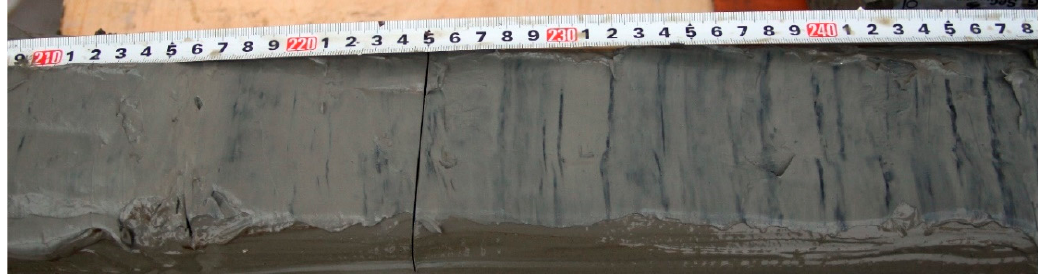
Figure 11. Core ONG-4. Banded diagenetic structure in Holocene silty-clay (Lithological units 1 and 2). Black bands are composed of manganese oxides and vivianite, rhodochrosite, siderite, and formations with various morphologies and degrees of crystallinity.